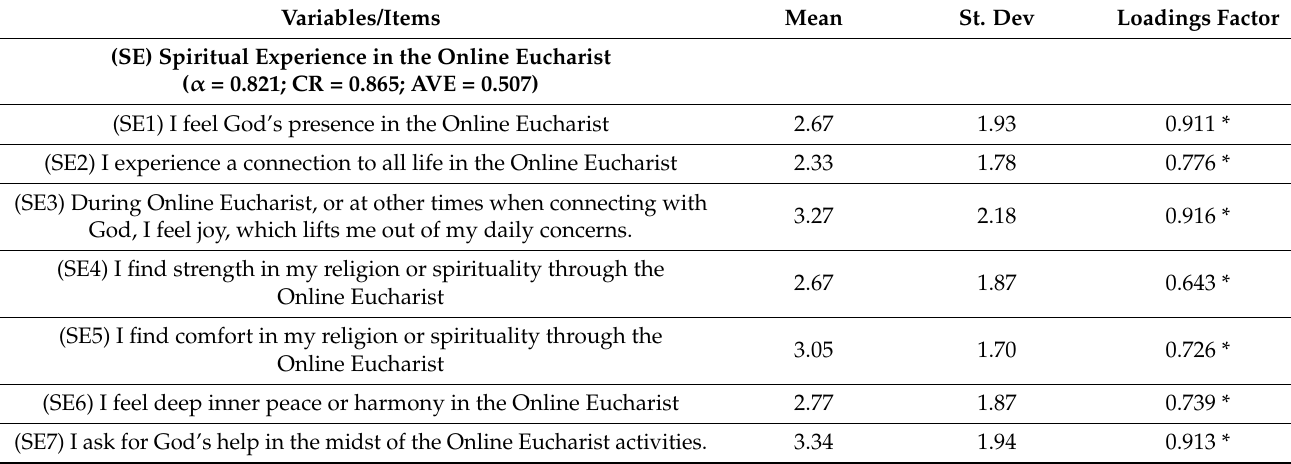
Table 4. Sources of measured